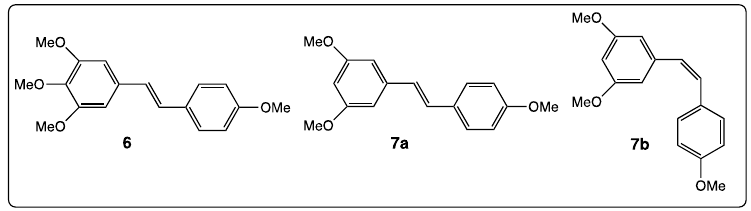
Figure 5 . Structure of DMU-212 ( 6 ), trans -3,4 ′ ,5-trimethoxyresveratrol ( 7a ), and cis-3,4 ′ ,5- trimethoxyresveratrol ( 7b ).